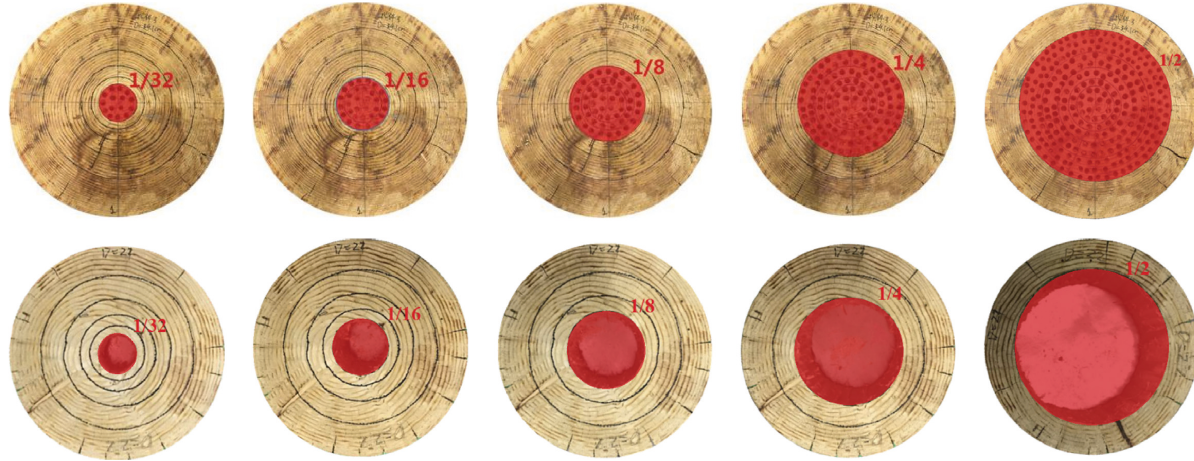
Figure 3: Shape of the simulated defective area.